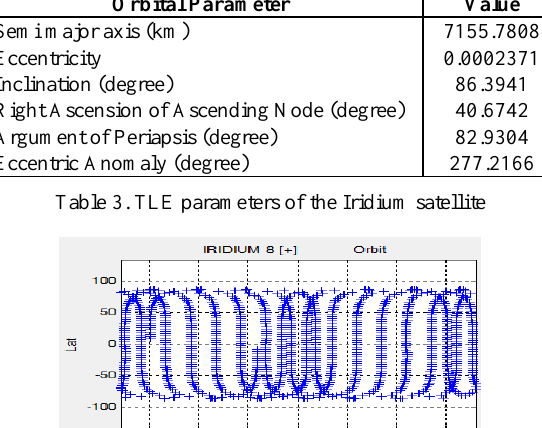
Table 1. The optical parameters to simulate images To simulate the point or streak of a satellite, different designs are considered for the TRM and SSM modes. Two fictitious point-like satellites near the center and top of the image are simulated for TRM. For the satellites which are bright enough, four or five images should be simulated. Thus, the magnitude of the first satellite is 2 and other one is 5. In Table 2, the orbital parameters of these satellites are given and Figure 7 illustrates the trajectory of them.